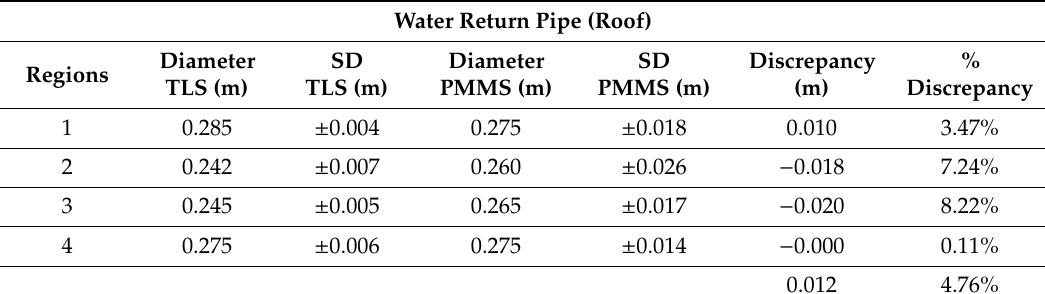
Table 5. Diameters discrepancies and standard deviations (SD) obtained from the RANSAC cylinder fitting of the pipes: water return pipe regions located in the roof (Figure